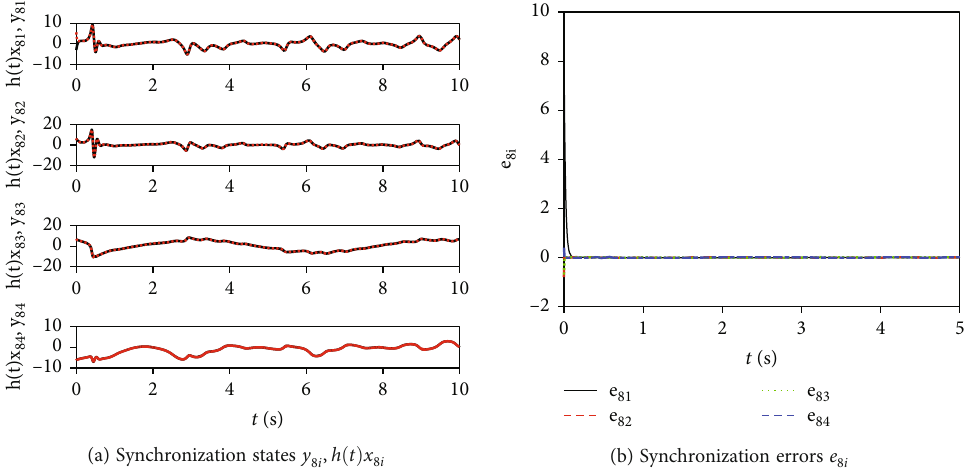
Figure 15: The time evolution of synchronization between y